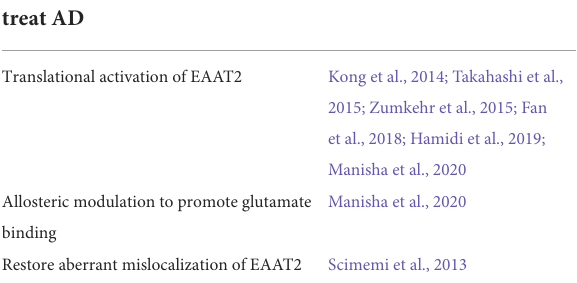
TABLE 3 A summary of possible avenues to restore EAAT2 function and treat Alzheimer’s disease. EAAT2 modulation strategies